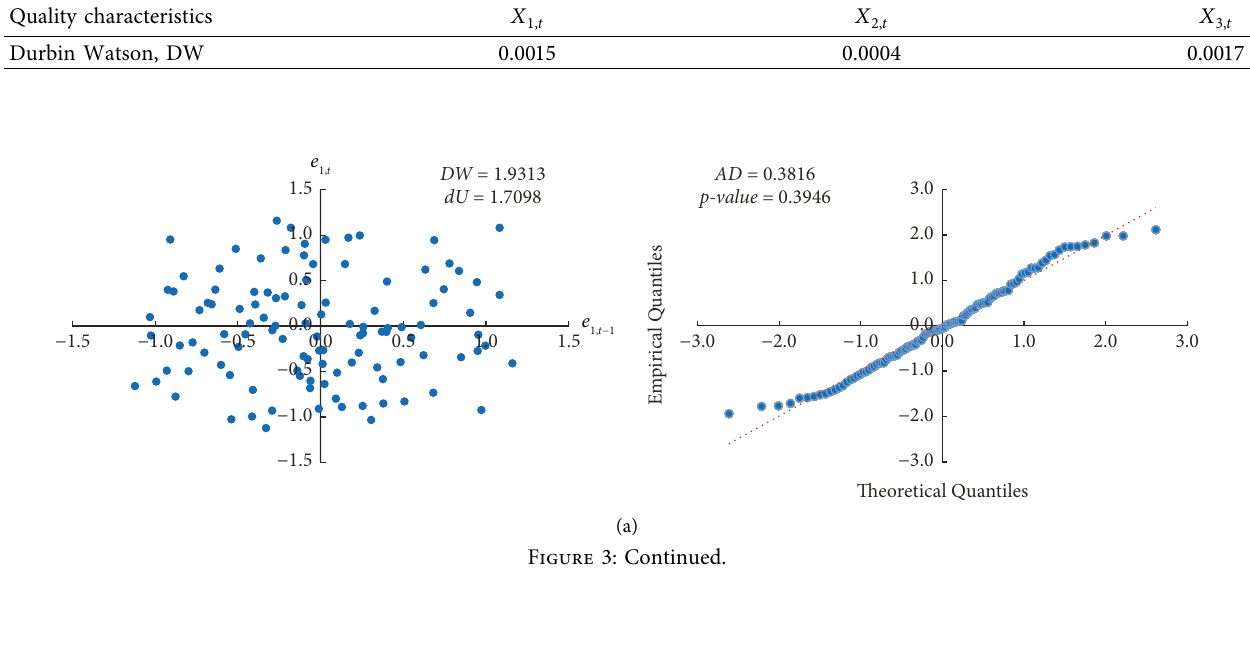
, X , and X 1 ,t 2 ,t 3 ,t